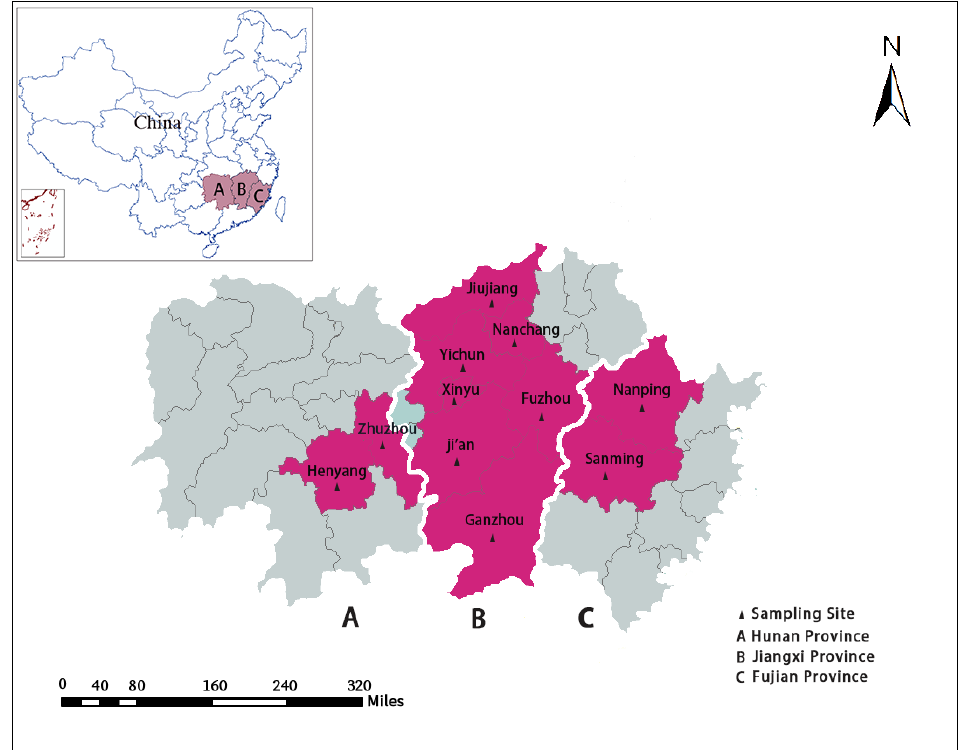
Figure 1. The map of the sample collection in this study, where the red area represents the sampling location.